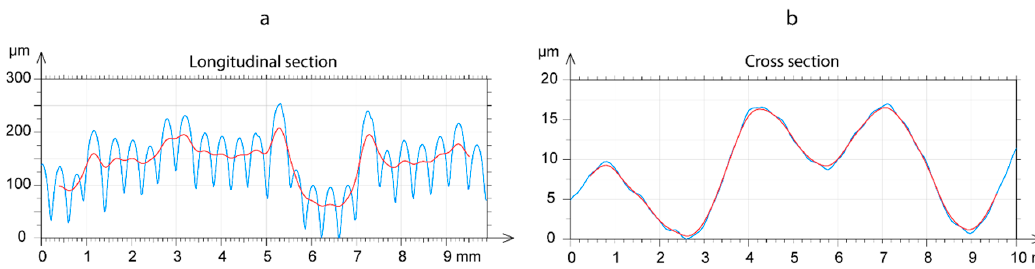
Figure 11. Detail of profile extraction in flat orientation: ( a ) Longitudinal and ( b ) cross-section.